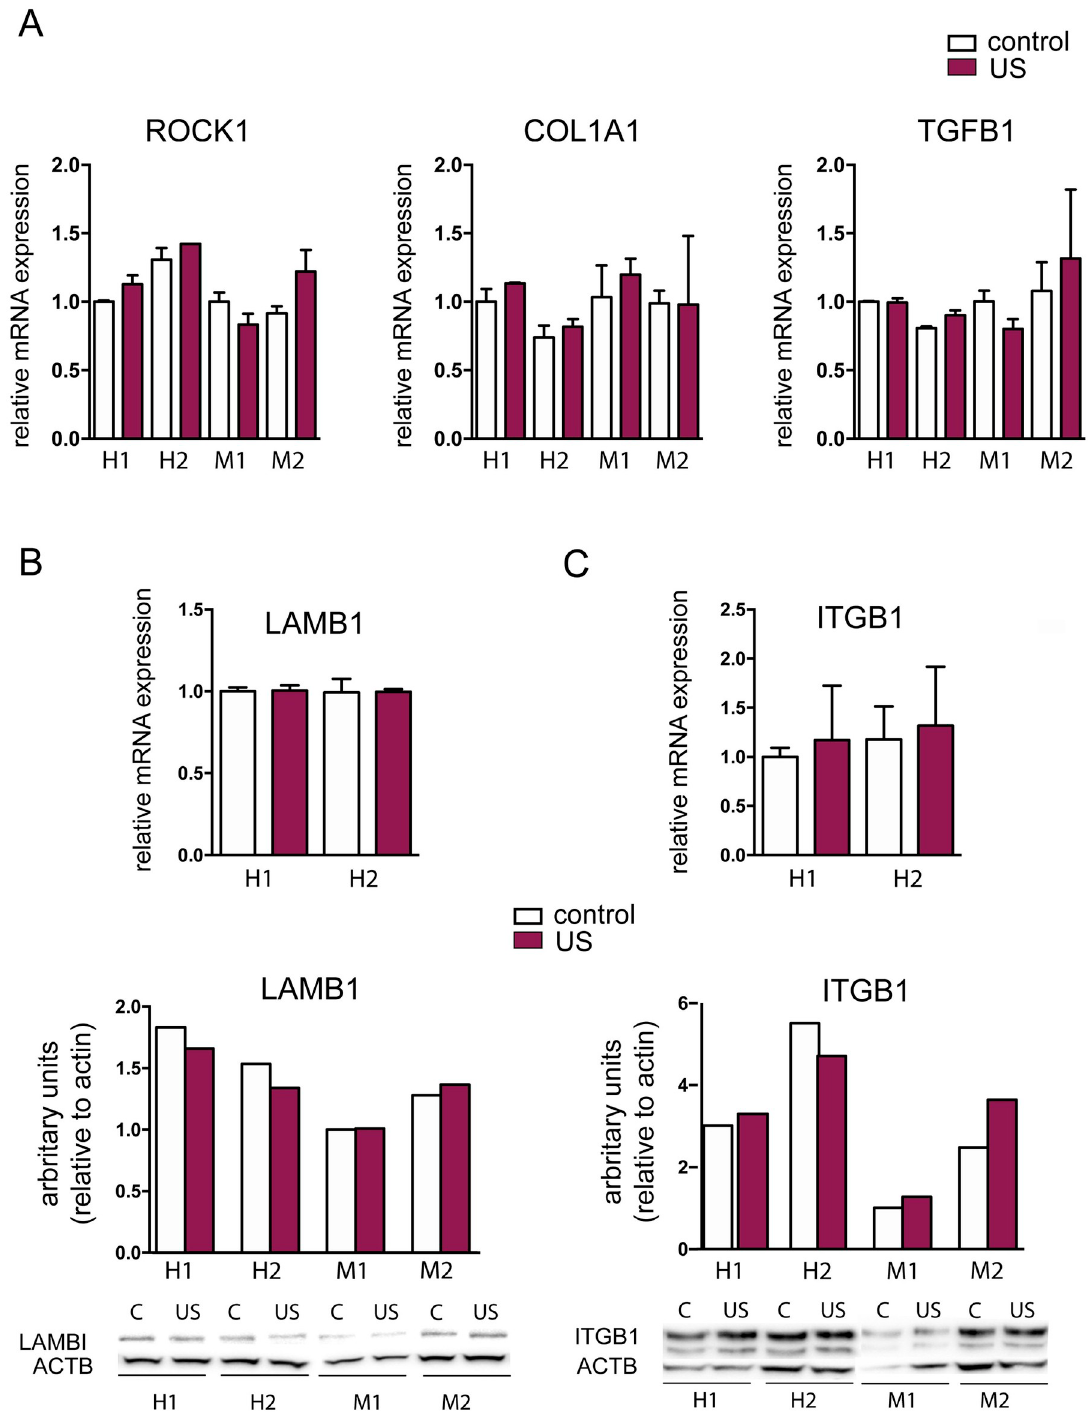
Fig 8. Gene and protein expression analysis. (A) Gene expression of ROCK1 , COL1A1 , TGFB1 . Data are shown from a representative experiment out of three performed and denote mean ± SD. (B) Gene and protein expression of LAMB1 , and ITGB1 . Data are shown from a representative experiment out of three performed and denote mean ± SD. Statistical analysis was performed using one-way ANOVA with Bonferroni’s multiple comparisons test. Shown are two independent samples of mouse (M1 and M2) and human (H1 and H2) s-MPs under control conditions or treated with ultrasound